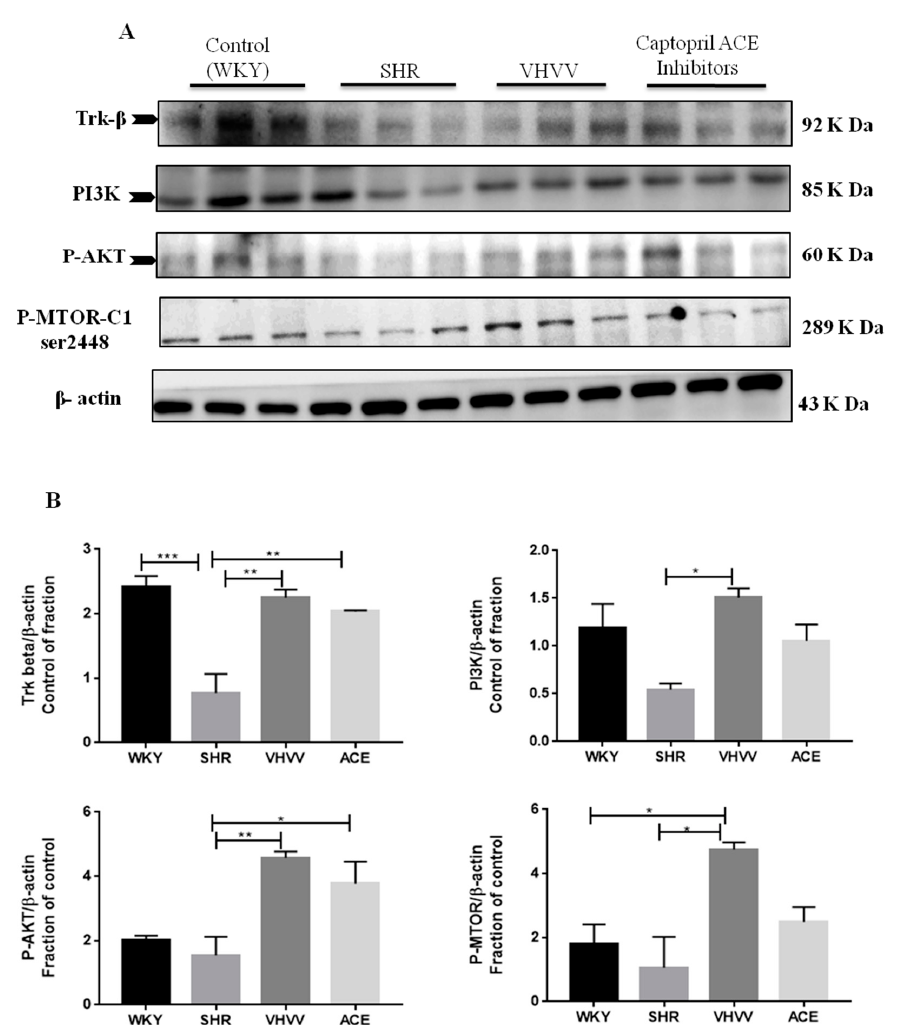
Figure 4. Effect of VHVV on neuronal cell survival through the PI3K-Akt-mTOR signaling pathway: Representative western blot results for tropomyosin receptor kinase B (Trk- β ), phospho-protein kinase B (P-AKT), phosphoinositide 3-kinase (PI3K), and phospho-mechanistic target of rapamycin (p-mTOR). ( A ) Proteins are overexpressed in the VHVV group animals compared with all other groups and were significantly downregulated in the SHR groups compared with the positive control ACE and control WKY groups. ( B ) Western blot analysis of the relative optical density of protein expression was conducted by ImageJ software. The data are presented as the mean ± standard error. * p < 0.05; ** p < 0.01, and *** p < 0.001.